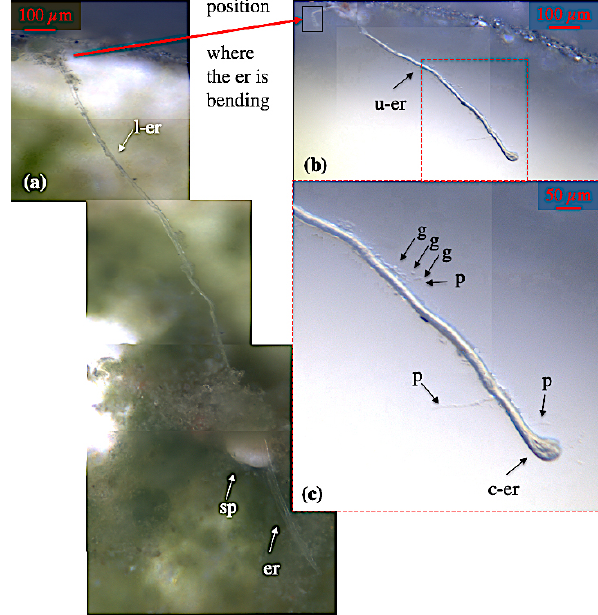
ulus specimen (sp) embedded in algae with two ectoplasmic roots (er) extending on the bottom of the aquarium. At one point, the northern ectoplasmic root bends upward at the aquarium’s wall; thus, it is differentiated in a lower (l-er) and an upper (u-er) part. Panel (b) shows the upper part of the northern ectoplasmic root. Panel (c) shows the u-er at higher magnification revealing granule (g), pseudopodia (p), and a broad contact zone (c-er) where the ec- toplasmic root is attached to the aquarium’s